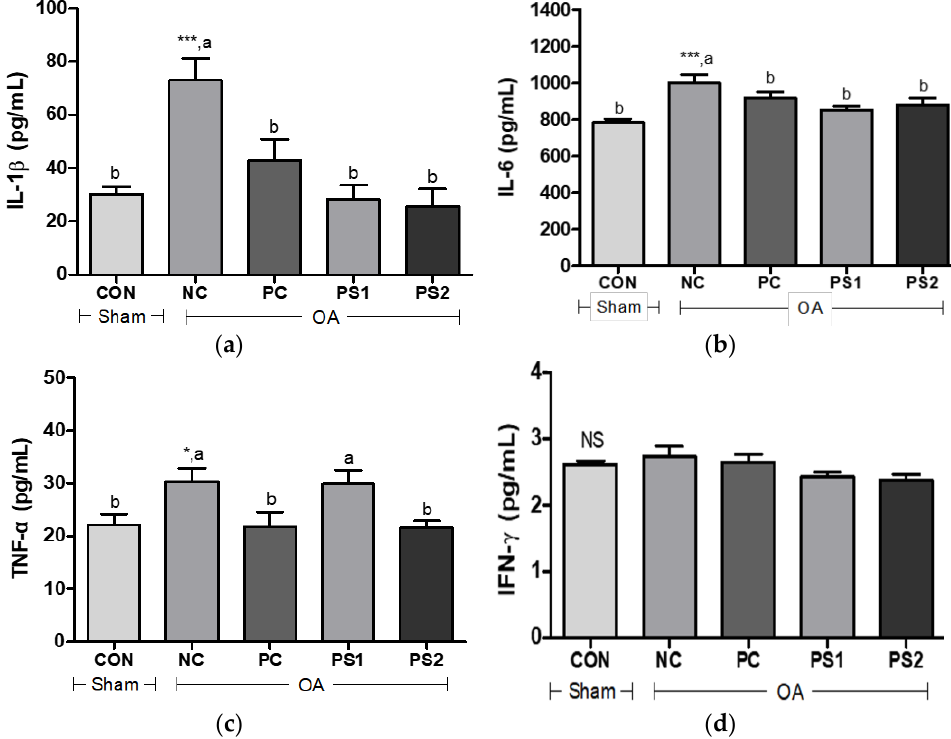
Figure 4. Effects of PS on serum inflammatory cytokine ( a ) IL- 1β, ( b ) IL-6, ( c ) TNF- α, and ( d ) IFN- γ levels in OA rats. CON: normal sham control; NC: negative control; PC: positive control; PS1: PS at 100 mg/kg BW; PS2: PS at 300 mg/kg BW. The data are presented as the mean ± SE (n = 4~5/group). NC group was significantly different from the CON group at * p < 0.05, *** p < 0.001 by Student’s t test. NS Not significantly different among groups. a,b Mean values with different letters are significantly different ( p < 0.05) among groups by Duncan’s multiple range test.